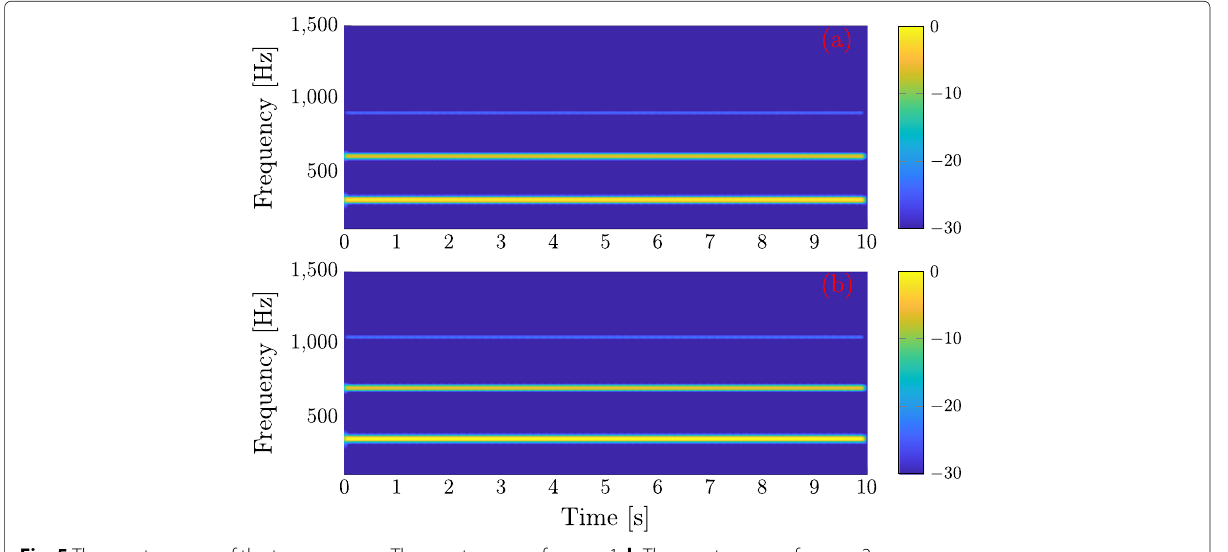
Fig. 5 The spectrograms of the two sources. a The spectrogram of source 1. b The spectrogram of source